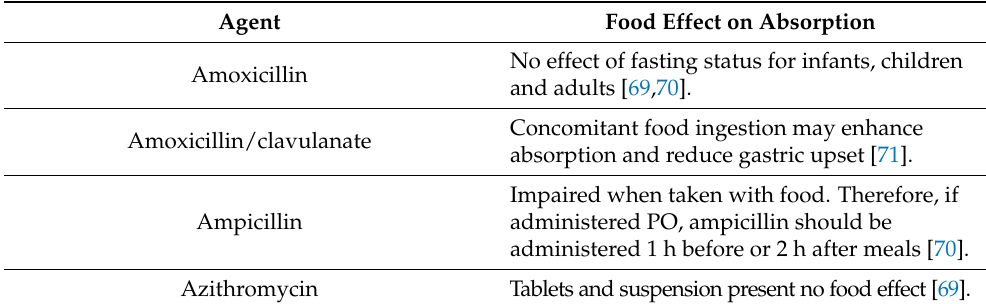
Table 2. Summary of antimicrobial-food